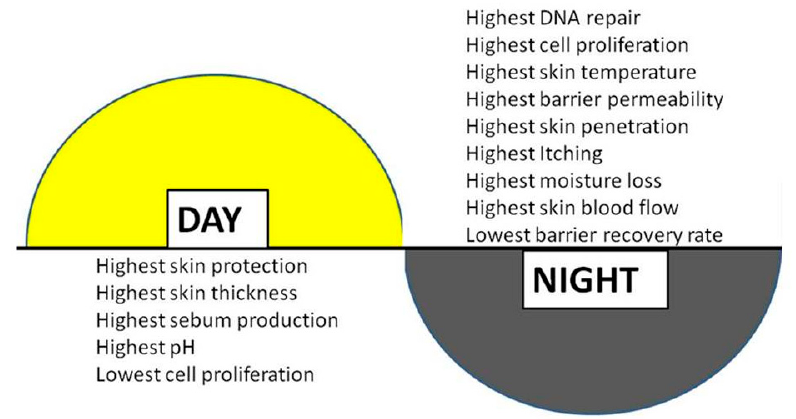
Figure 3. The oscillation of human skin properties as they cycle through the day and night. For example, sebum production has been shown to be higher during the daytime that at night. Higher values for itch and moisture loss occur during the evening. Adapted from, Harry’s Cosmeticology 9th Edition , Pernodet and Pelle with permission